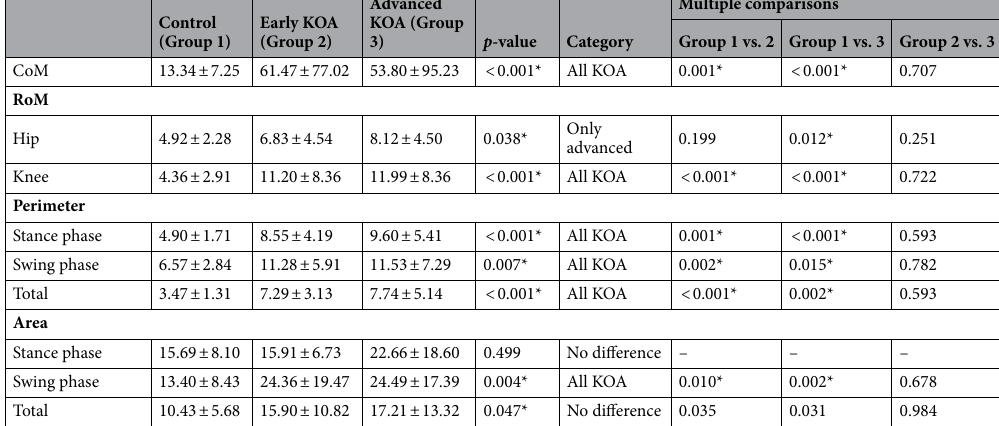
Table 3. The coefficient of variance (CV) for hip-knee cyclogram parameters between groups. Values are mean ± standard deviation. P value by Kruskal–Wallis test and multiple statistical differences between groups by Mann–Whitney U test with Bonferroni correction. KOA knee osteoarthritis, CoM center of mass, RoM range of motion. *Significant difference between